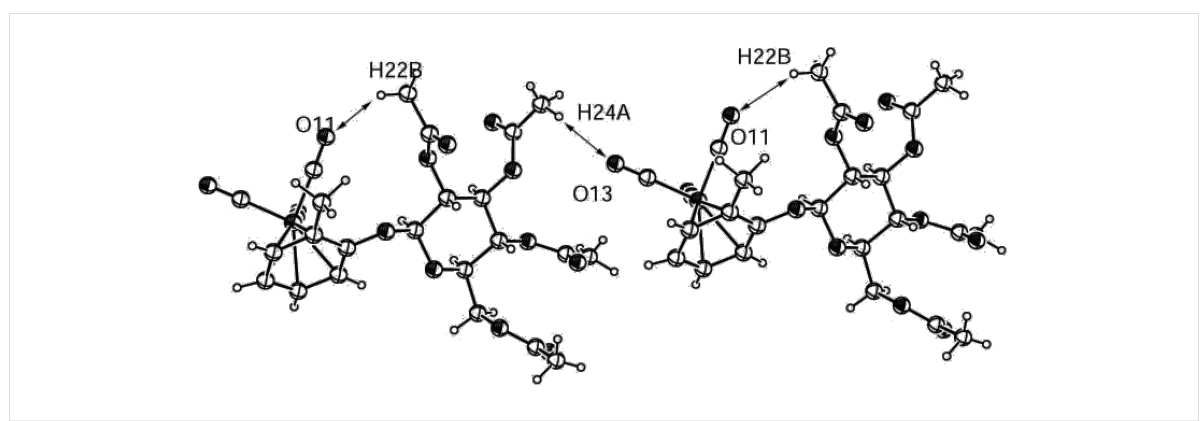
Figure 9: ORTEP-plot of the asymmetric unit showing two molecules of compound pR -2m and 30% probability ellipsoids; the arrows show the nonclassical intramolecular H-bonds between O11 and H22B and the intermolecular ones between O13 and H24A.